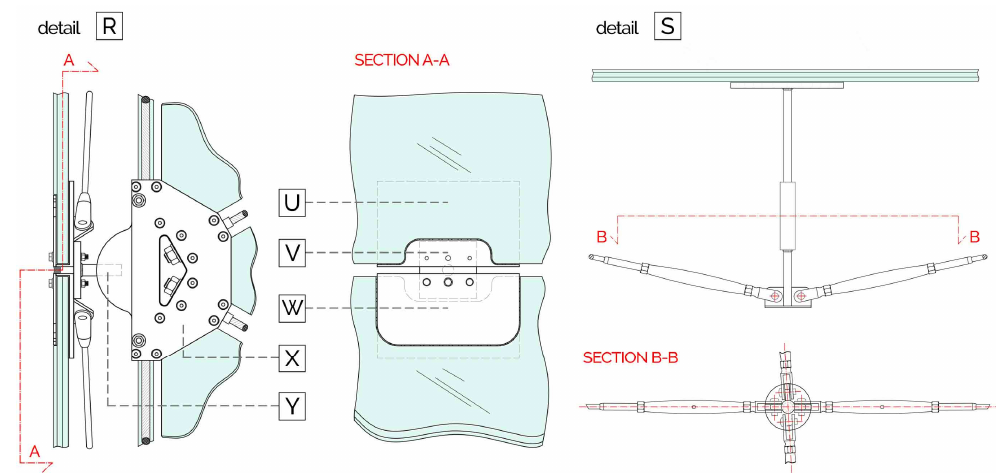
Figure 9. Details of the bracing panels: U) Glass panel with rounded recesses; V) steel plate (compression only contact with the glass); W) outer steel clamping; X) TVT γ‐ bis node; Y) steel pole.